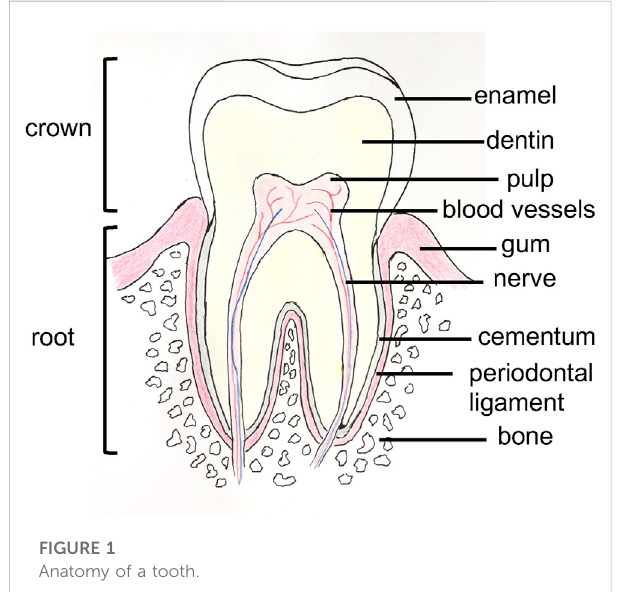
FIGURE 1 Anatomy of a